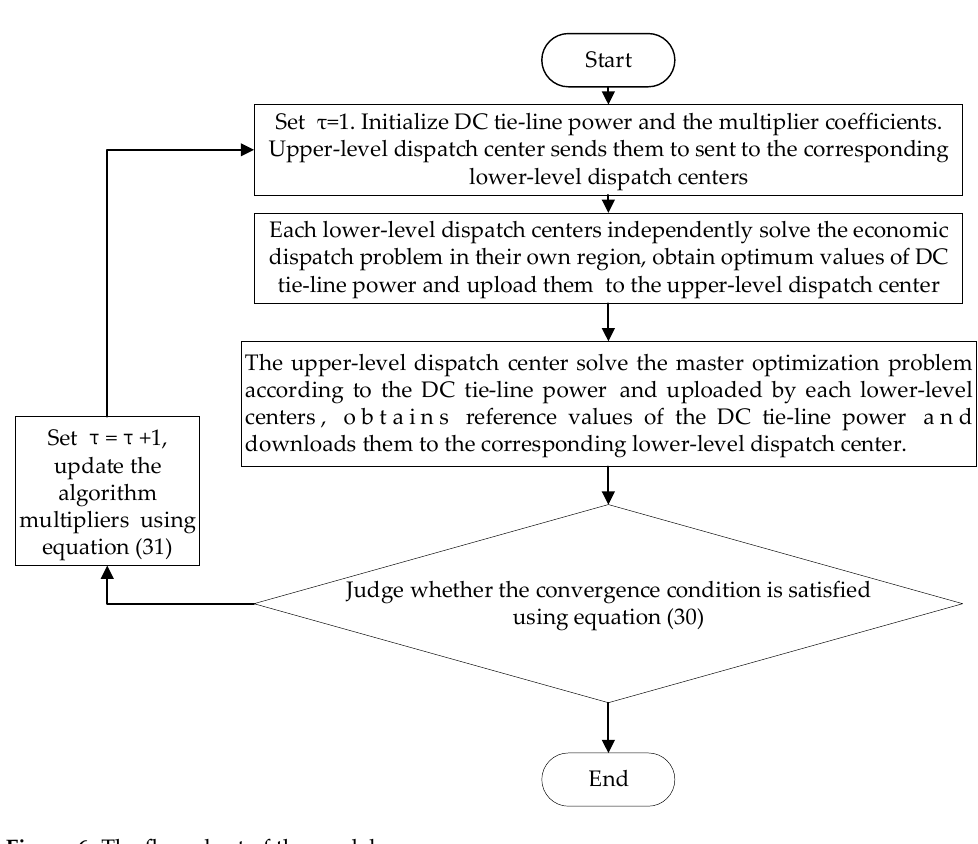
Figure 6. The flow chart of the model.